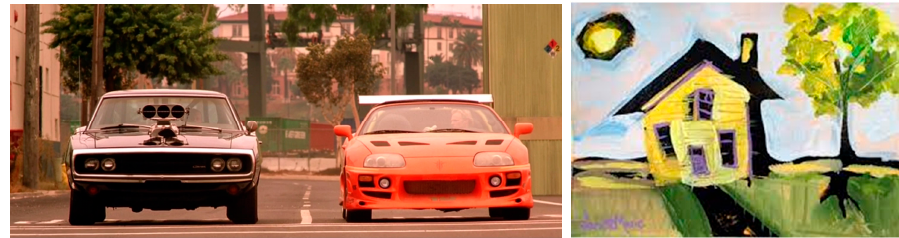
Figure 5. The image used for comparison; left—content image; right—style image.